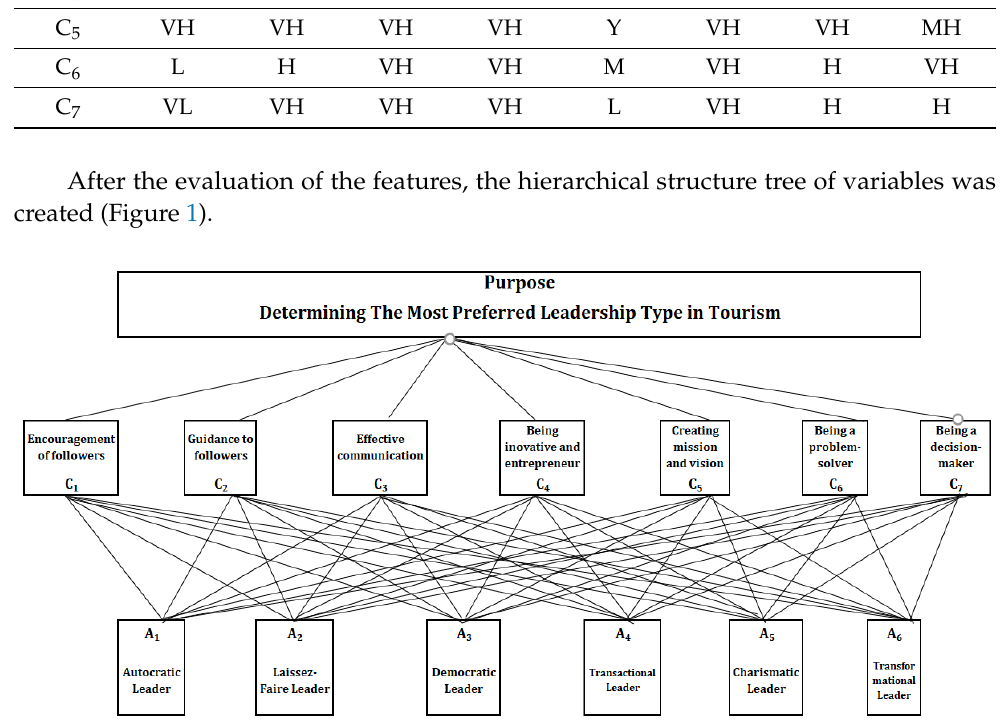
Figure 1. The hierarchical analysis model.